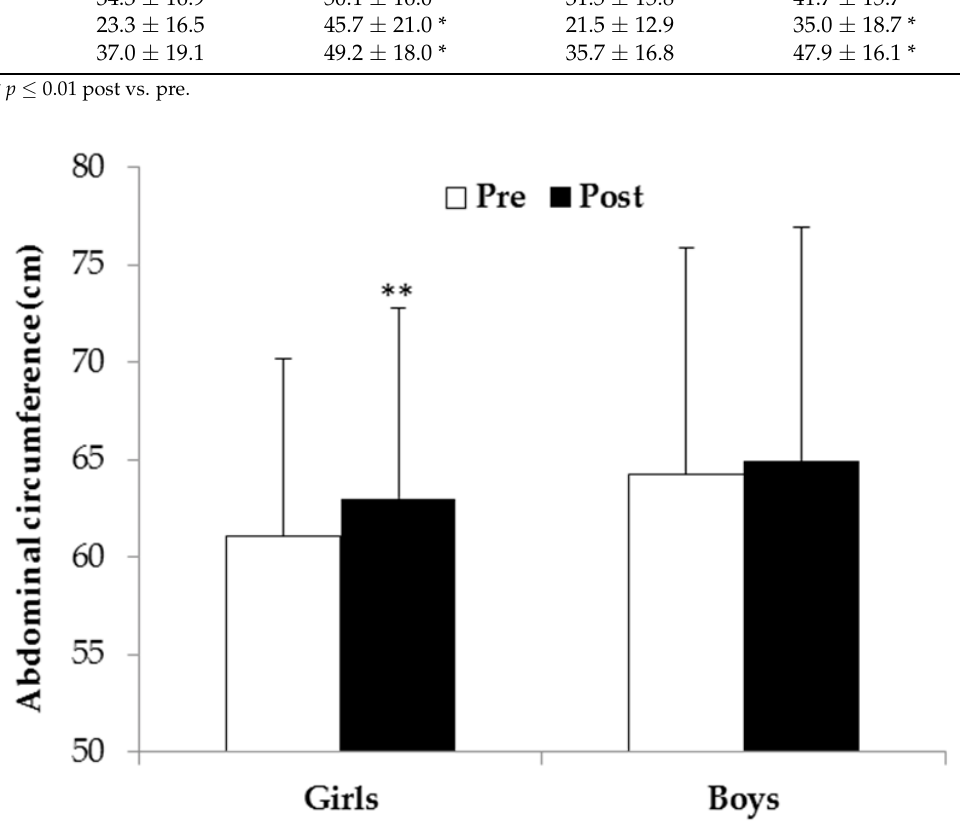
Figure 1. Abdominal circumference of girls and boys before (Pre) and after (Post) intervention (** p < 0.001).